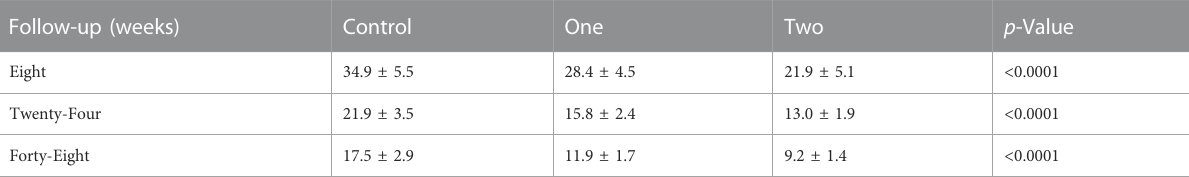
TABLE 4 MRI-based ATFL SNR value a . Follow-up